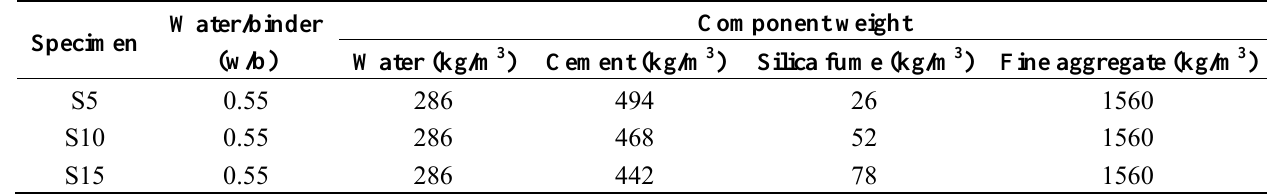
Table 6. Mix design of cement with silica fume—Type S specimen.